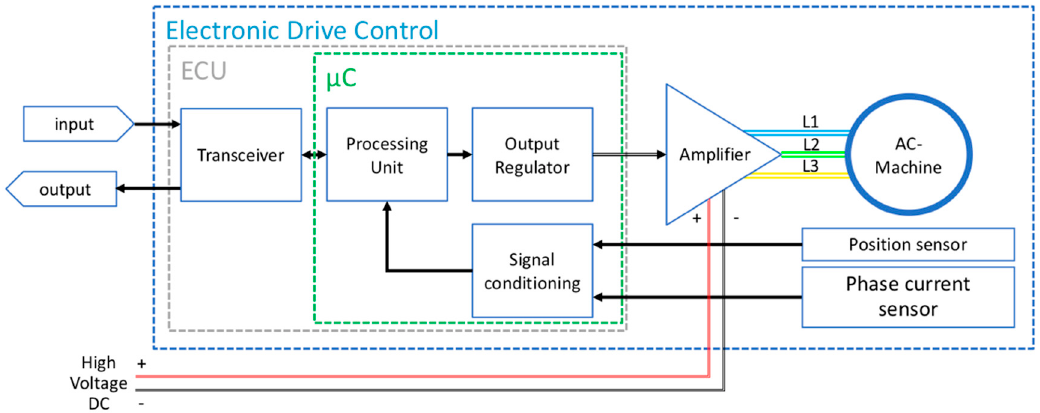
Figure 6. Detailed electric drive control architecture for closed loop control.